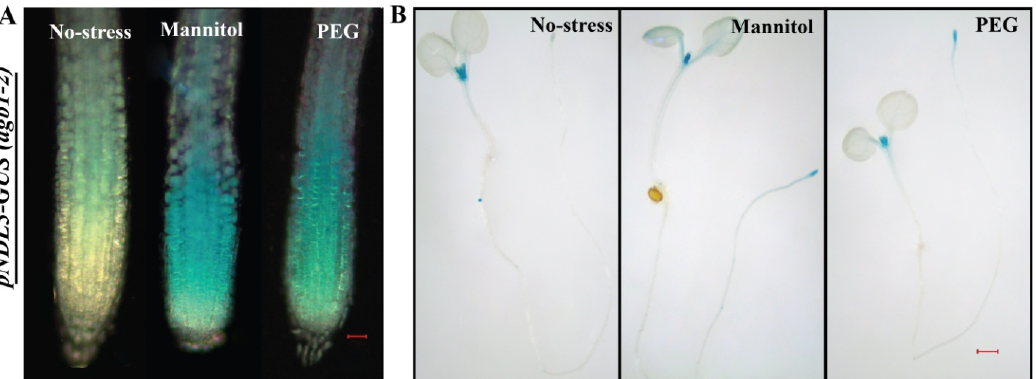
Figure 9. In vivo histochemical GUS staining of 6-day old transgenic Arabidopsis seedlings ( pNDL3-GUS ) in agb1-2 mutant background: ( A ). Increased levels of GUS staining intensity were detected in RAM compare to almost no staining in no treatment control with Mannitol and PEG treatment. ( B ) Histochemical GUS staining was analysed in whole seedling also. ne Six days old Arabidopsis transgenic seedlings were subjected to treatment for 24 h. Result shown is representative of three independent biological replicates ( n ≥ 10 in each experiment). Scale Bar = 0.2 μM for seedlings and 0.02 μM for RAM.